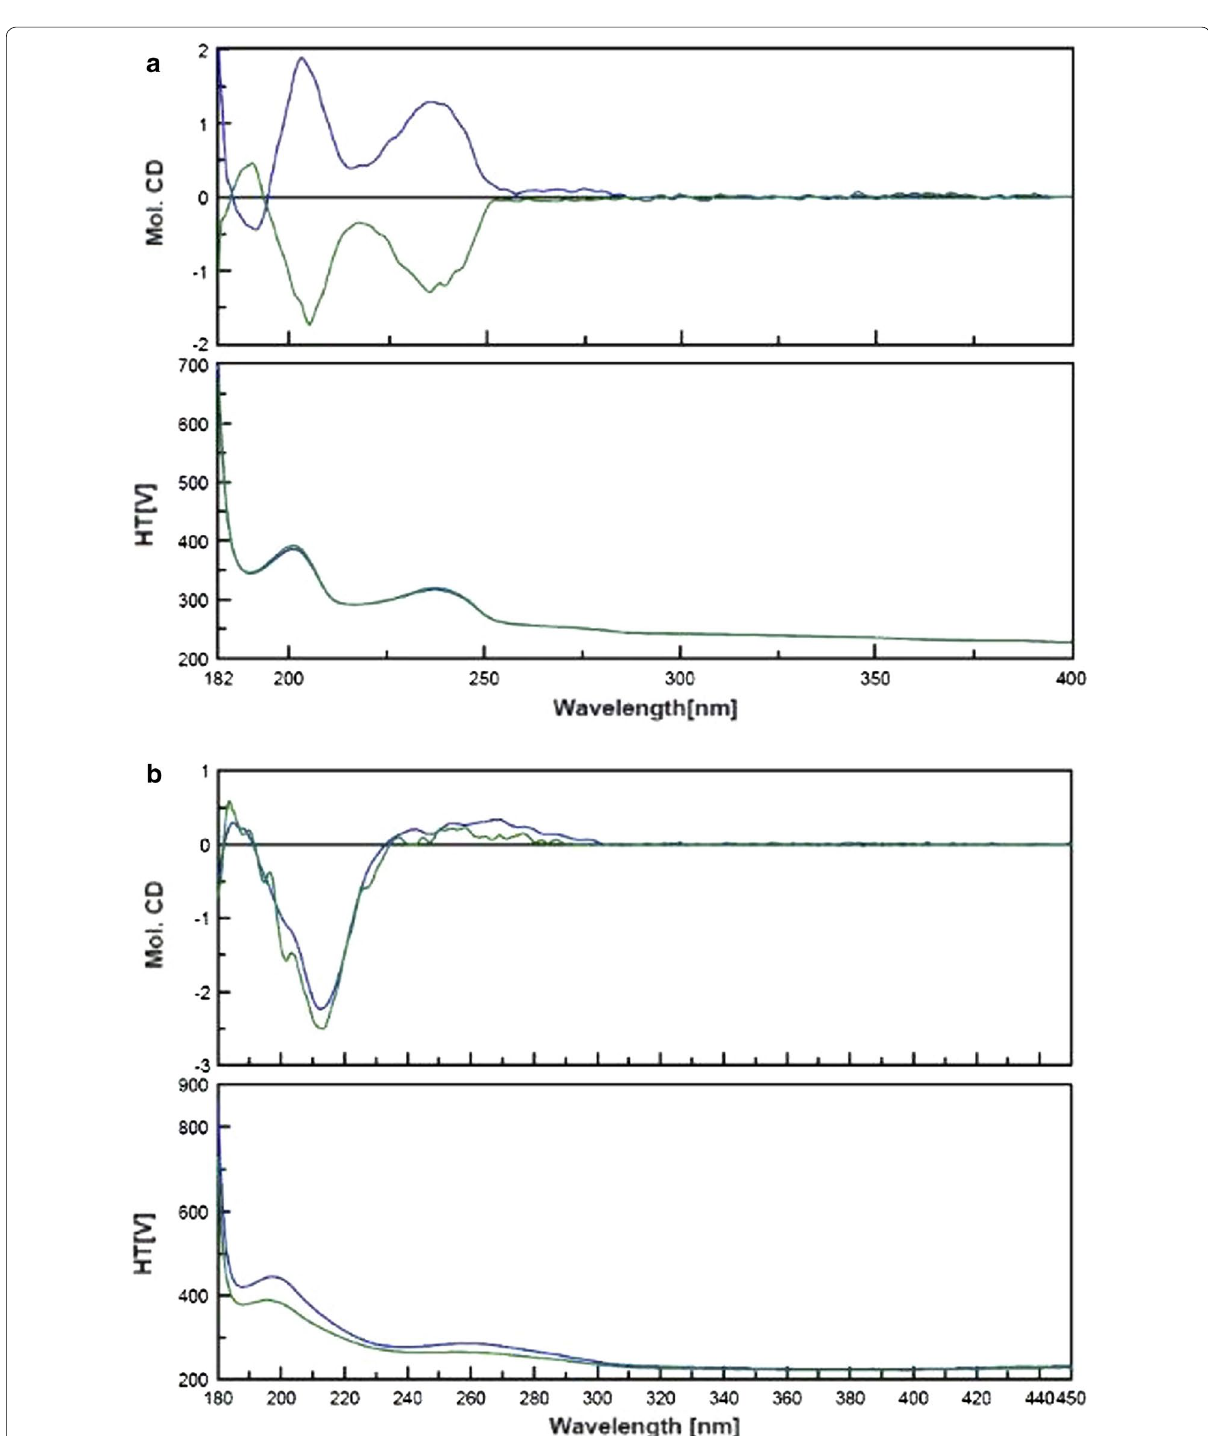
Fig. 2 The comparison of electronic circular dichroism spectra of a ( S )‑ ( blue ) and ( R )‑ 5 ( green ), and b synthesised ( S )‑radezolid ( blue ) and reference material ( green